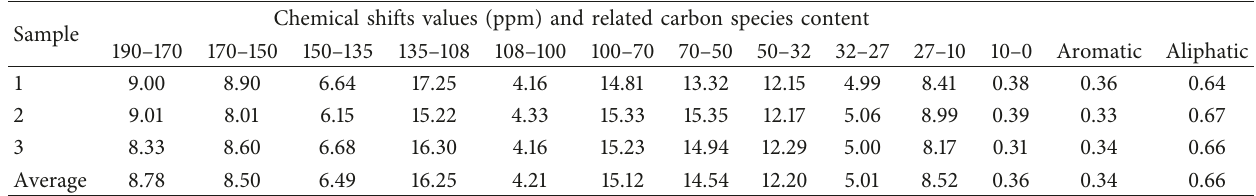
Table 3: Carbon species in humic acids of soils